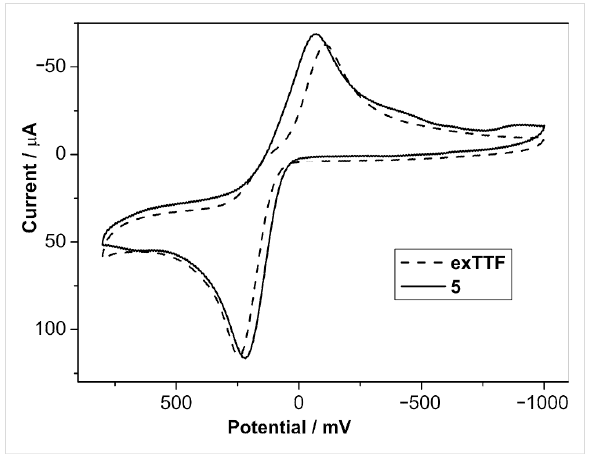
Figure 2: Cyclic voltammograms of compound 5 and pristine exTTF (at concentrations of approximately 0.2 mM) using THF as a solvent and TBAPF 6 (0.1 M) as a supporting electrolyte. Scan rate: 0.1 Vs − 1